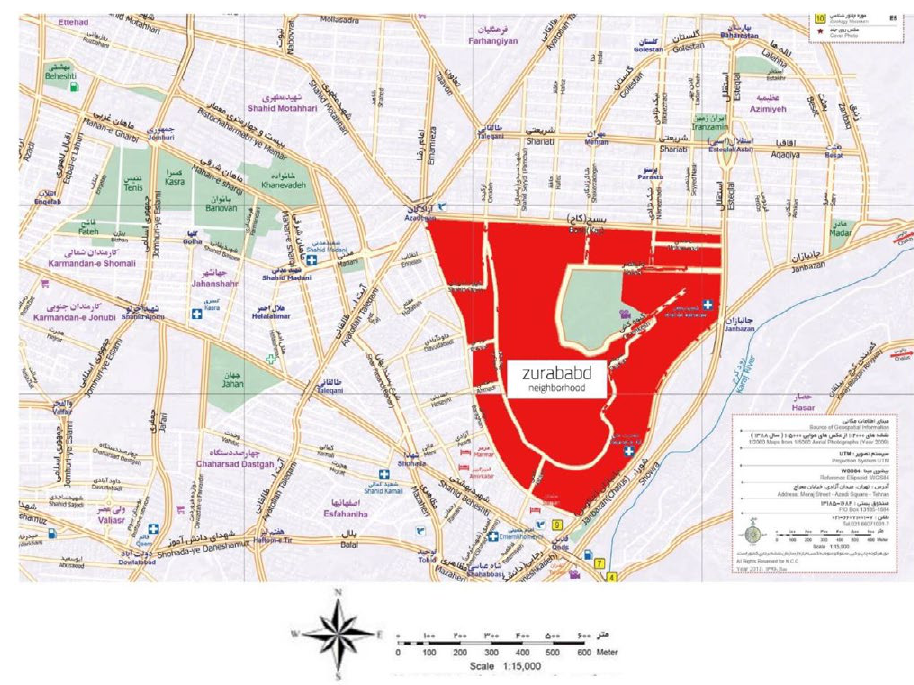
Fig.3: District 1, Zurabad Neighborhood (Map of karaj, 2019)